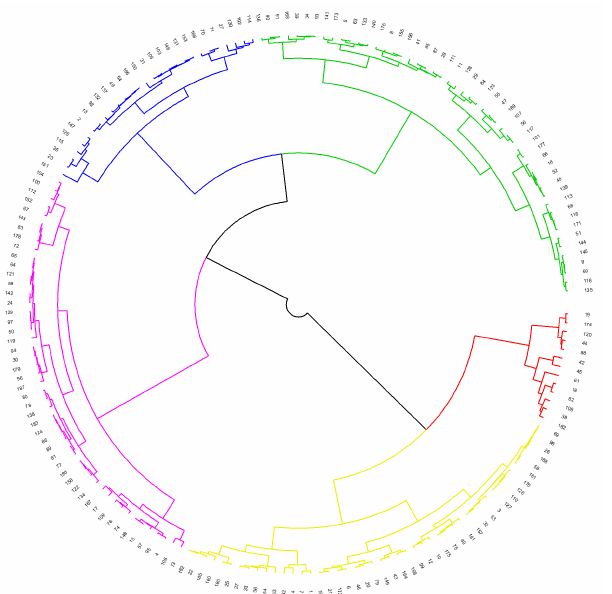
Figure 3. The dendrogram of the hierarchical agglomerative clustering in the form of a flower